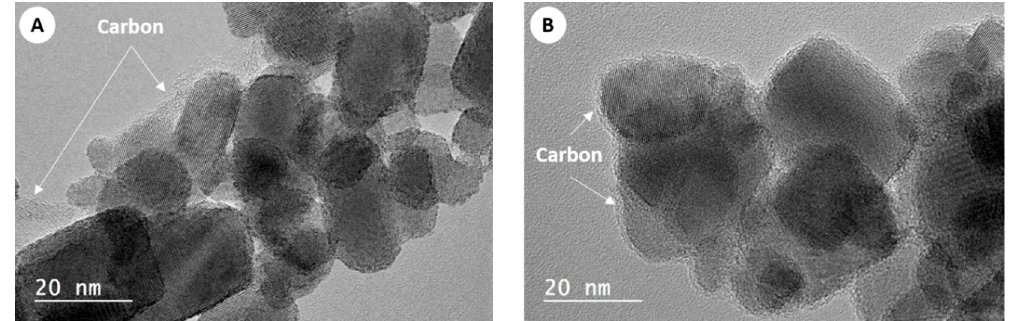
/ C suc and ( B ) WO 3 3